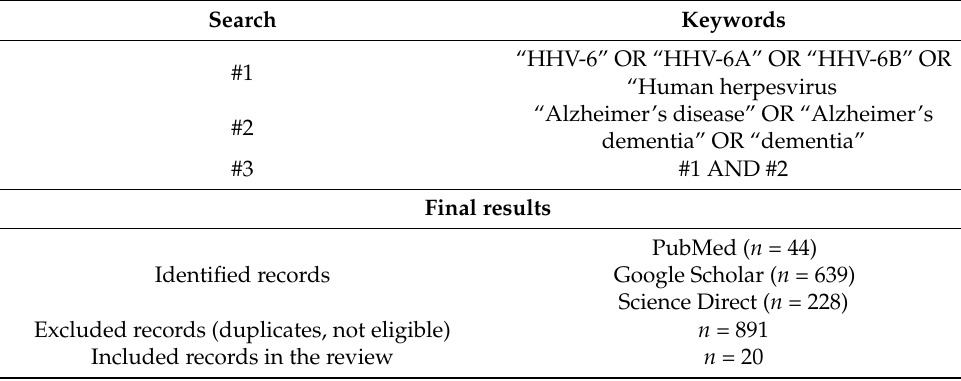
Table 1. The keywords used and the literature search strategy.